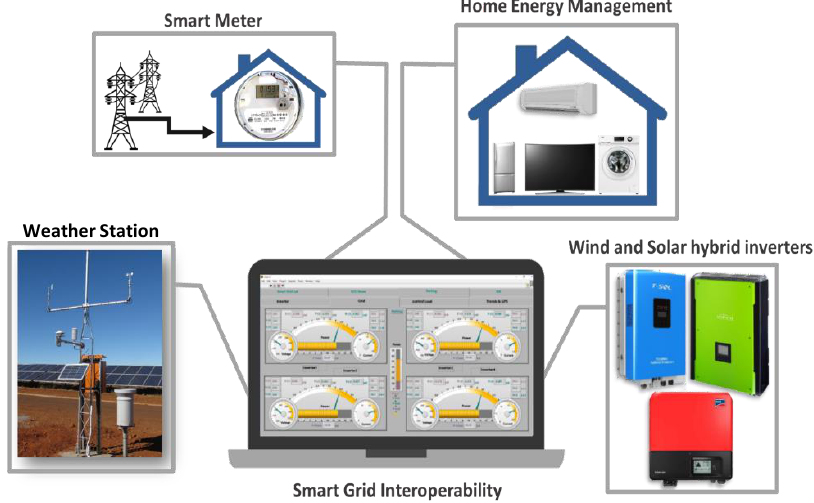
Figure 2. An RES monitoring system. The monitoring system collects and logs data from solar panels, wind turbines, storage batteries, inverters, smart meters, and an optional weather station.